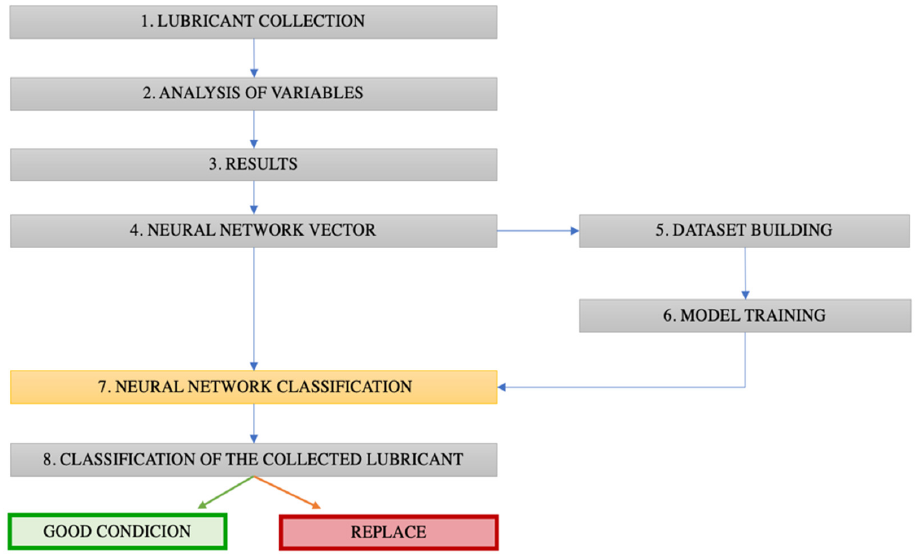
Figure 7. Methodology used to classify the lubricating oil of the press.